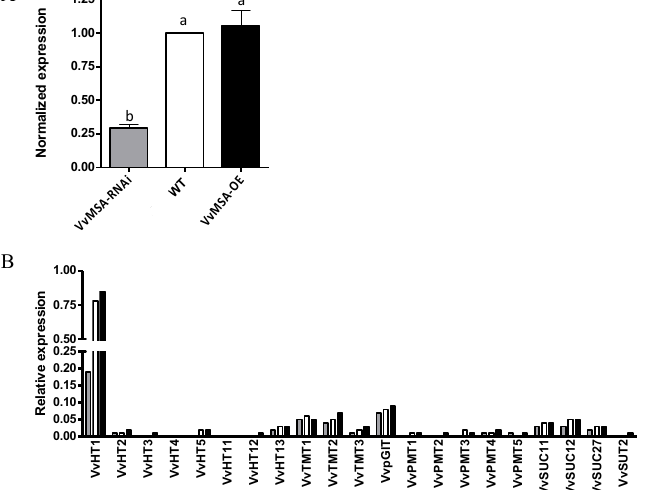
Figure 3. Expression of sugar transporters in WT, VvMSA-OE and VvMSA-RNAi embryogenic cells (EC) after 8 days of culture. ( A ) RT-qPCR analysis of the VvHT1 expression. The relative expression of the VvHT1 gene is calculated by the ΔΔ Ct method using VvGAPDH as a reference gene and VvMSA in WT as a control gene. The histograms show the mean of three independent experiments performed on 8-day-old cells (±SEM). The letters denote the groups that were found significantly different by ANOVA and Fisher LSD test ( p < 0.05) . ( B ) Macroarray analysis of sugar transporter expression. The histograms show the mean of two independent experiments performed on 8-day-old cells. Expression values are normalized using four housekeeping genes VvGAPDH , VvActin , VvEF1a , VvEF1 γ .